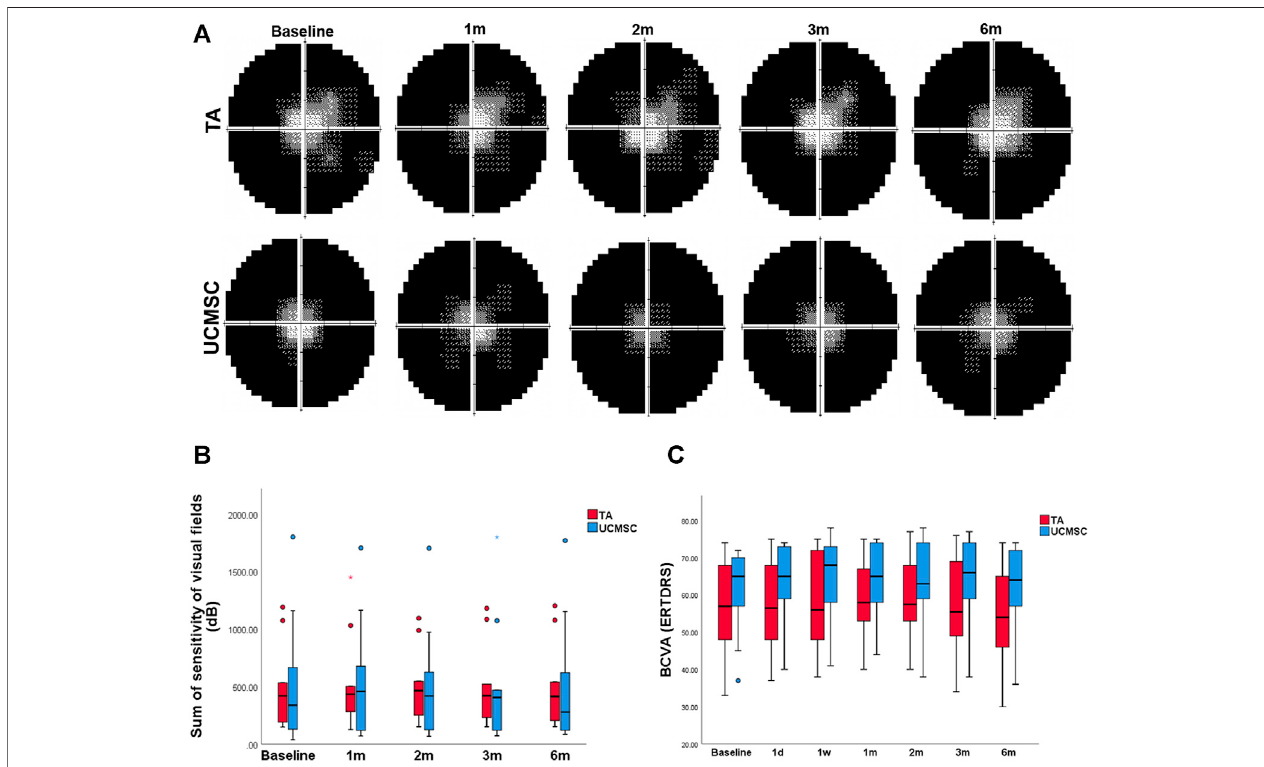
FIGURE4| AssessmentsofBCVA and visual fi eld sensitivity. (A, B) Thesum ofvisual fi eldsensitivity inTAgroup peaked at the second month without asigni fi cant difference ( p > 0.05, n (cid:2) 20, Wilcoxon signed-rank test), and then decreased tothe baseline level at the sixth month. In the UCMSCs infusion group, thisvalue increased at fi rst, second and third month without signi fi cant differences ( p > 0.05, n (cid:2) 20, Wilcoxon signed-rank test). Then it decreased to baseline value at sixth month. There were no signi fi cant differences found within each group or between the two groups ( p > 0.05, n (cid:2) 20, Mann – Whitney U test). (C) There were no signi fi cant differences of BCVA found within each group or between the two groups ( p > 0.05, n (cid:2) 20, Wilcoxon signed-rank test and Mann – Whitney U test).